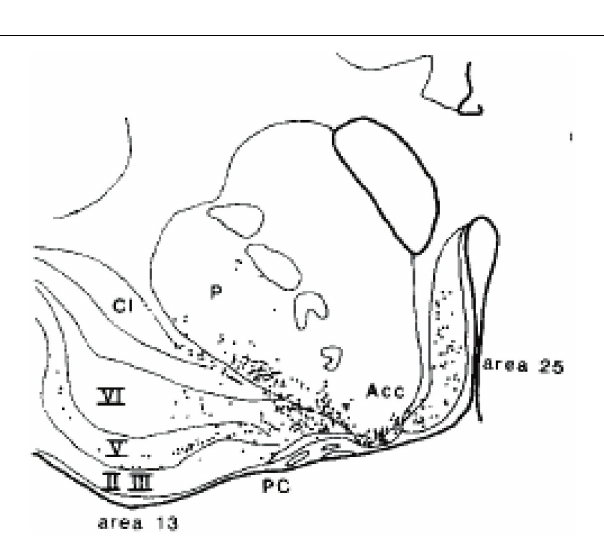
FIGURE 5 | Projection neurons from the insula deep layers to the cholinergic basal forebrain (Russchen etal., 1985).